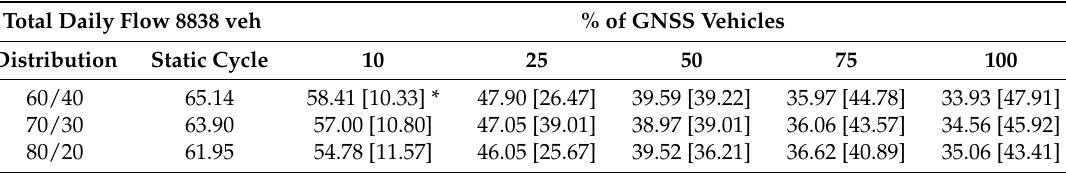
Table 4. Average travel time [sec.] in a typical day for Case B: inefficiently regulated